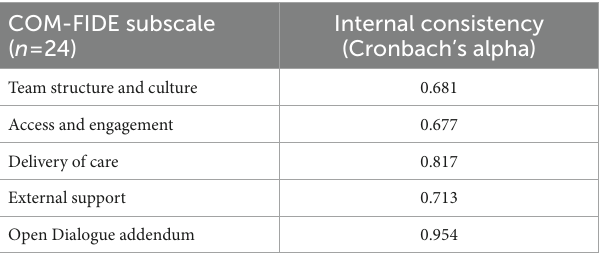
TABLE 3 Internal consistency of COM-FIDE